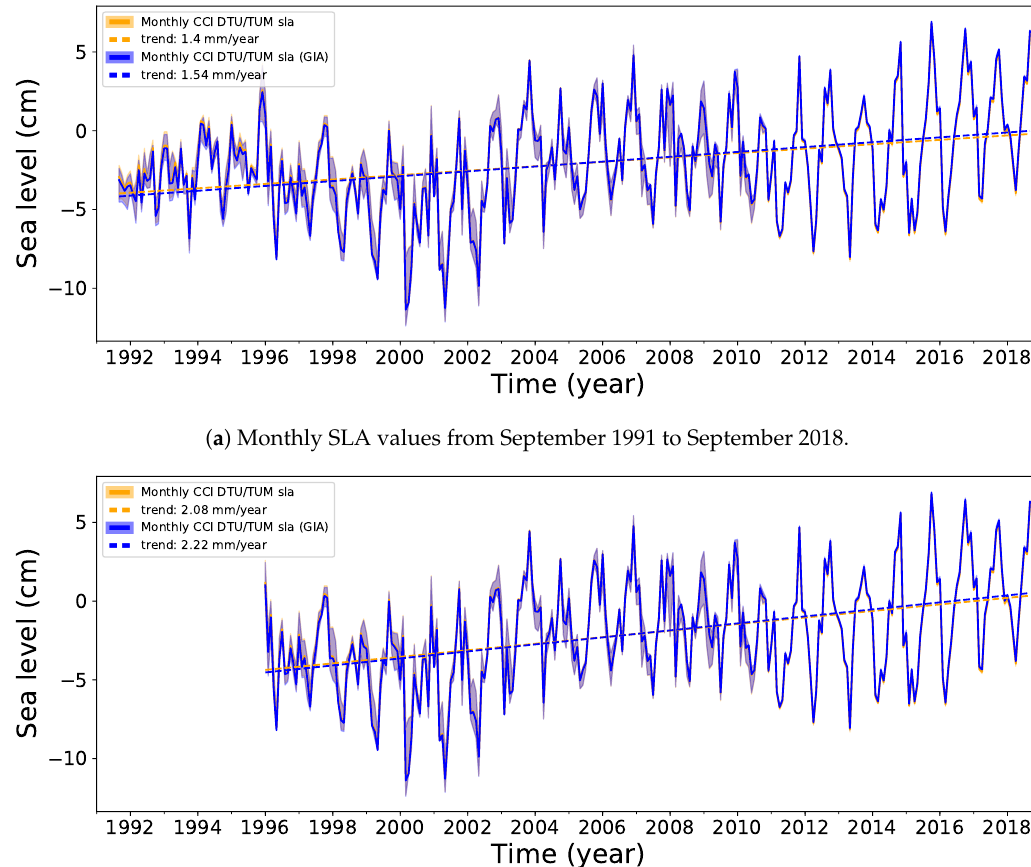
Figure 6. Monthly SLA values. ( a ) From September 1991 to September 2018 with a linear trend of 1.54 and 1.40 mm/year with a 95% confidence level of data laying within 1.16 to 1.81 and 1.01 to 1.67 mm/year with and without GIA correction, respectively. ( b ) From January 1996 to September 2018 with a linear trend of 2.22 and 2.08 mm/year with a 95% confidence level of data laying within 1.67 to 2.54 mm/year and 1.52 to 2.40 mm/year with and without GIA correction, respectively. The blue and yellow shadows are the 95% confidence level for measurements with GIA and without GIA,